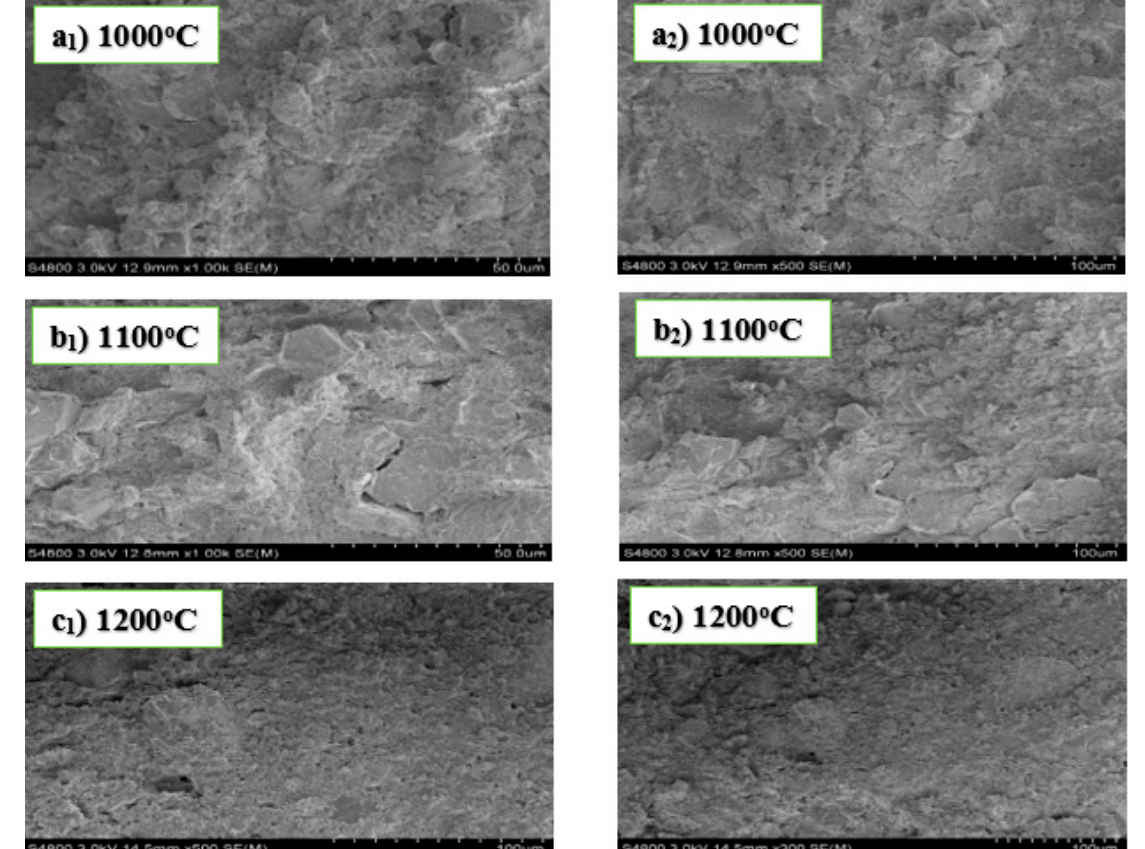
◦ C ( b ◦ C ( c 1 , a 2 ), 1100 1 , b 2 ), and 1200 1 , c 2 ).